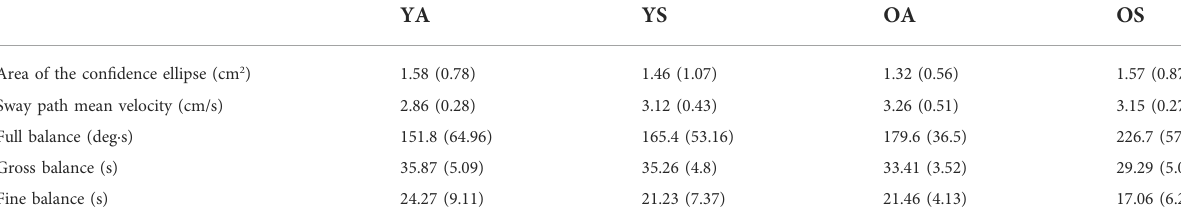
TABLE 1 Results of the static and dynamic tests. Data are presented as Means and Standard deviations.